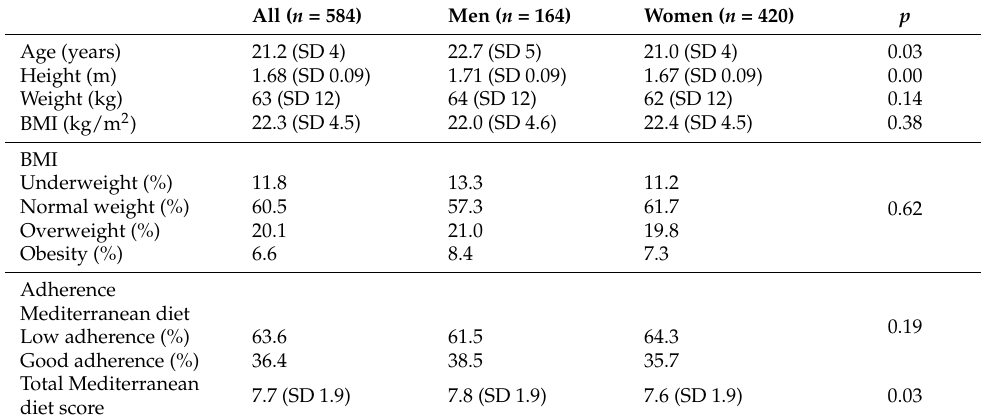
Table 1. Descriptive characteristics of the study sample by sex.